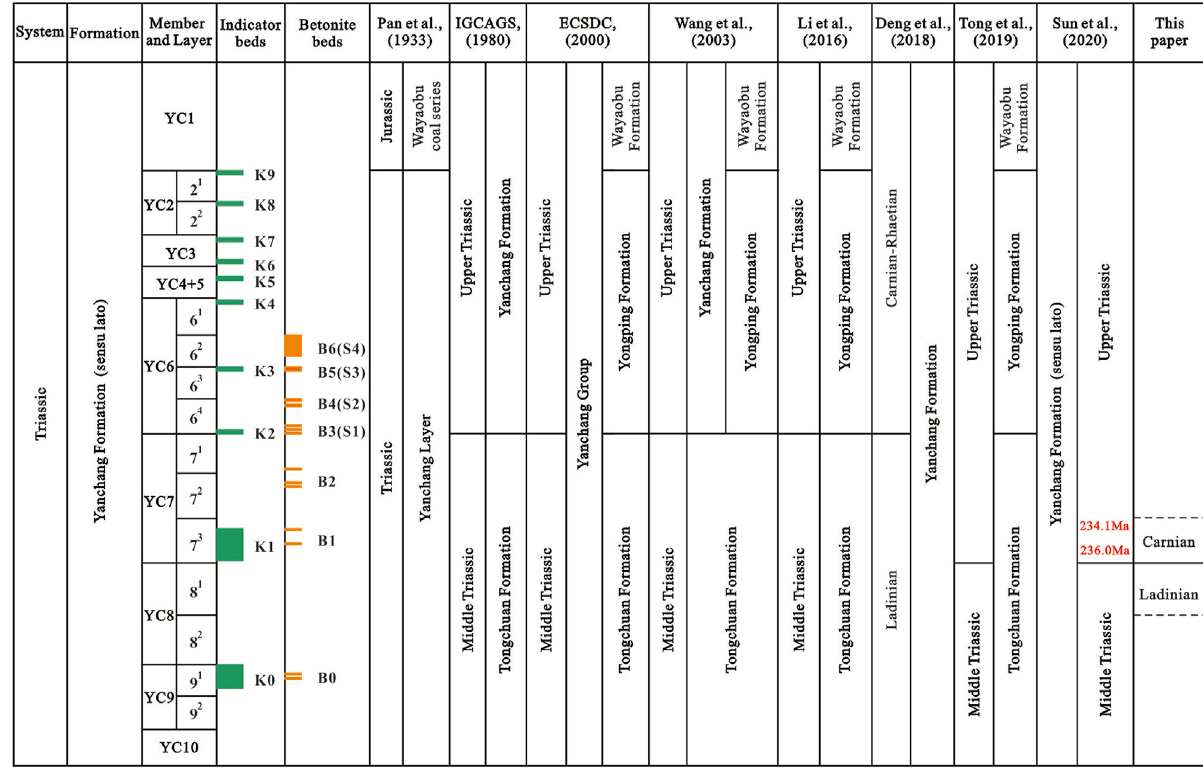
TABLE 1 Historical division of the Yanchang Formation ( sensu lato ) in Ordos Basin,